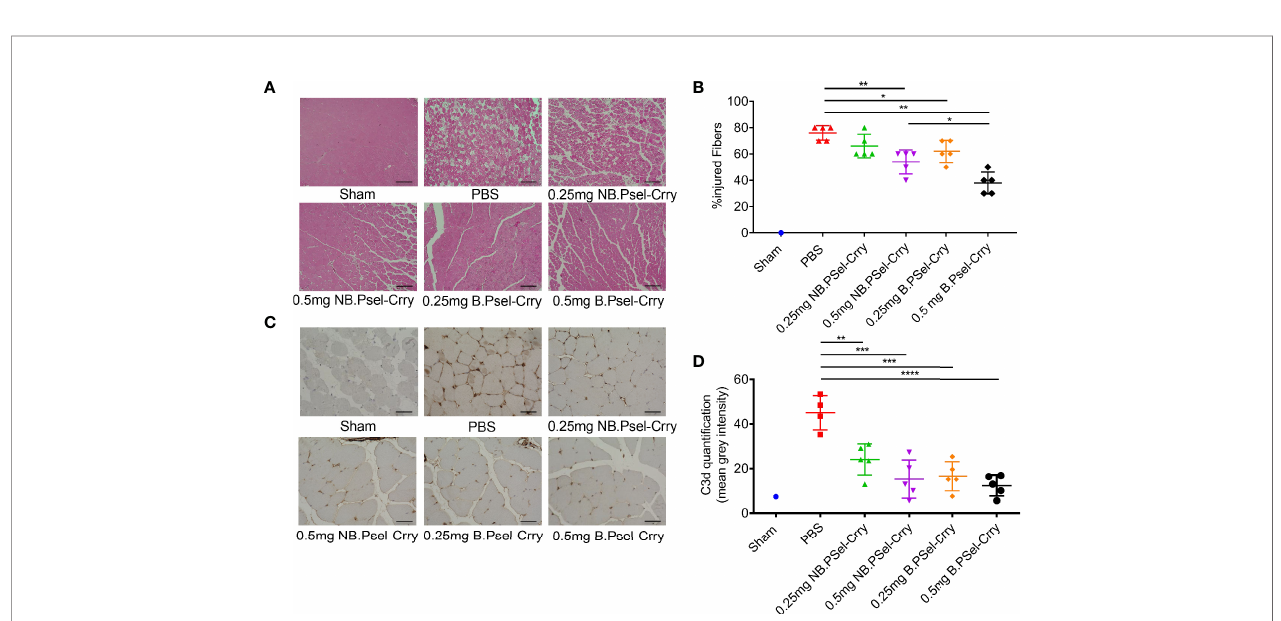
FIGURE 2 | B.PSel-Crry and NB.PSel-Crry reduce injury after hindlimb ischemia and reperfusion. A murine hindlimb IRI model was used to evaluate the effect of B.PSel and NB.PSel administered i.v. upon reperfusion after 2 h ischemia. (A) Representative H&E stained muscle sections revealed reduced skeletal muscle injury, edema, and myeloid cell in fi ltrate in mice treated with B.PSel or NB.PSel as compared to the vehicle control (PBS). Scale bars, 200 m m. (B) Quanti fi cation of IRI, showing reduction in histology injury scores with both constructs. At higher dose of 0.5 mg, B.PSel-Crry was signi fi cantly more protective than NB.PSel-Crry. No injury was seen in the sham injected mice. Non-parametric One-Way ANOVA (Kruskal-Wallis) with Dunn ’ s correction. (C) Representative images of sections stained for C3d deposition. Scale bars, 50 m m. (D) Quanti fi cation of C3d deposition. Parametric One-Way ANOVA with Tukey ’ s correction. Quanti fi cation data expressed as Mean ± SD, *p ≤ 0.05, **p ≤ 0.01, ***p ≤ 0.001, ****p ≤ 0.0001. n = 5 for all